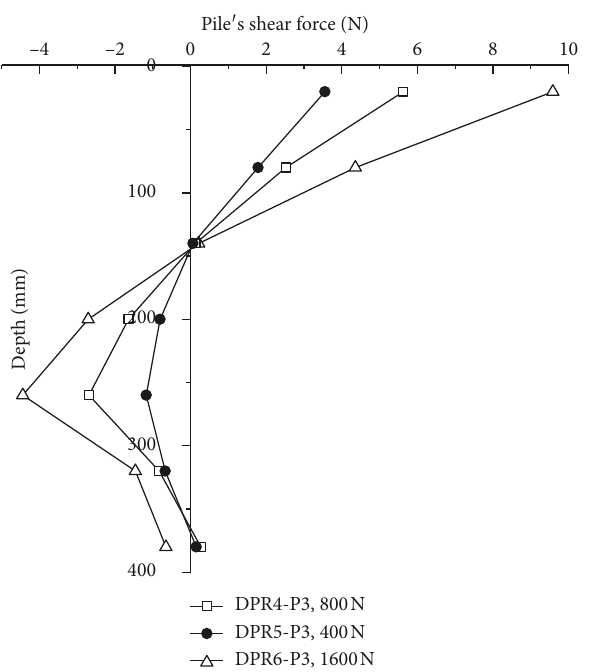
Figure 10: Influence of the interposed layer on the responses of the pile shear force under a 300N horizontal force.